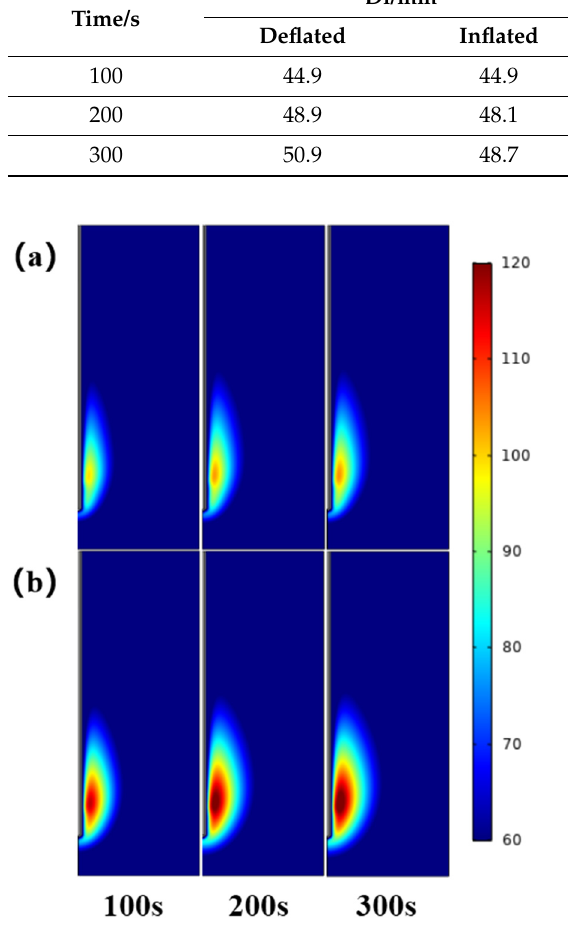
Figure 8. Thermal field distribution of microwave ablation Power = 40 W, ( a ) inflated group; ( b ) deflated group.